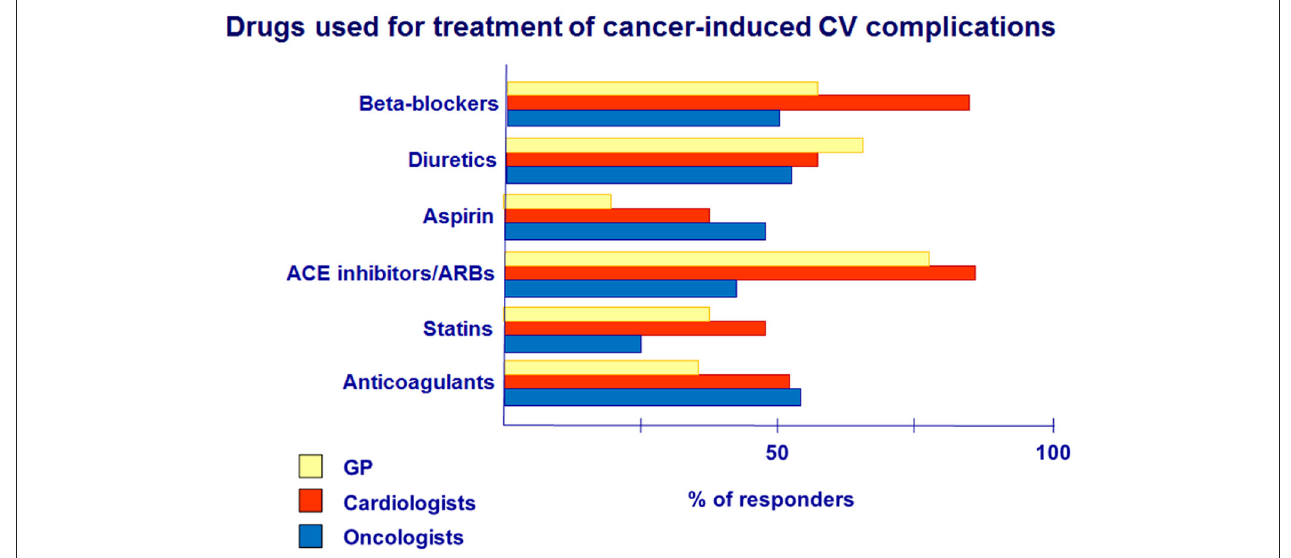
FIGURE 6 | Drugs used for the treatment of cancer-induced CV complications.